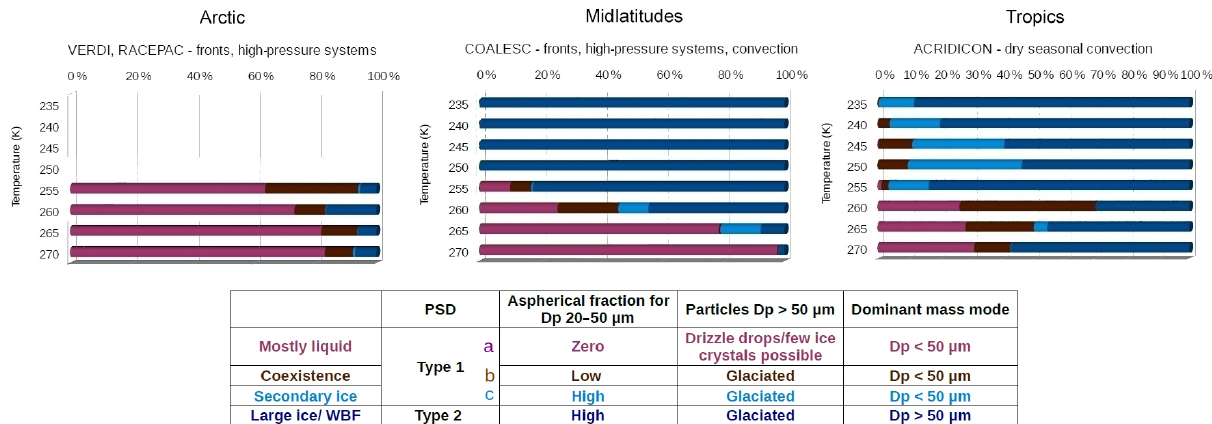
Figure 15. Occurrence of the cloud types defined in Sect. 3.3: Type 1a/mostly liquid clouds are dominated by small, exclusively spherical par- ticles (for details on the particle size distributions (PSDs), see Sect. 3.1). They have high overall number concentrations. Type 1b/coexistence clouds are dense too, but do contain some small aspherical particles, indicating that a glaciation process has begun. The Type 1c/secondary ice cloud type is again very dense – the particle numbers exceed the INP concentration estimations by far (see Sect. 3.2). Here, most of the small particles in the size range between 20 and 50µm are aspherical; the cloud must therefore consist of ice. In contrast, clouds in the category Type 2/WBF and large ice show low overall number concentrations. These clouds are dominated by large ice particles which may resume from the Wegener–Bergeron–Findeisen process or, especially in the tropics, be large, sedimenting ice aggregates from cumulonimbus anvils.